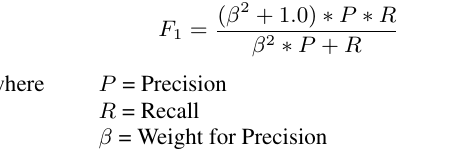
Table 1. Training configurations of the networks tested